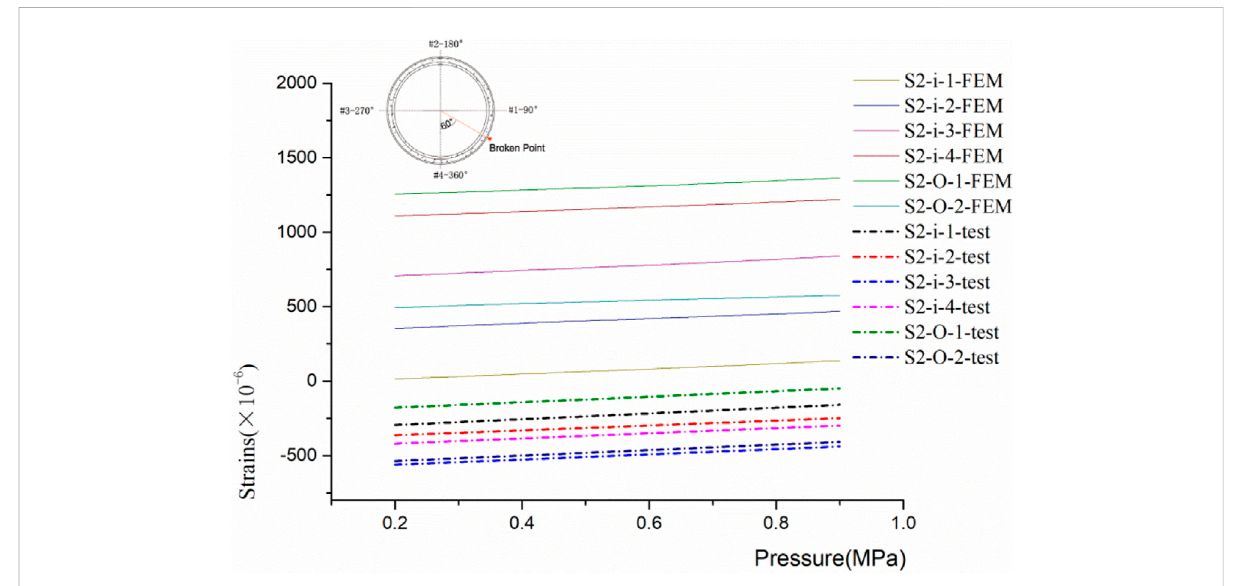
FIGURE 18 Comparison of FEM and test results of the concrete core at stage V.